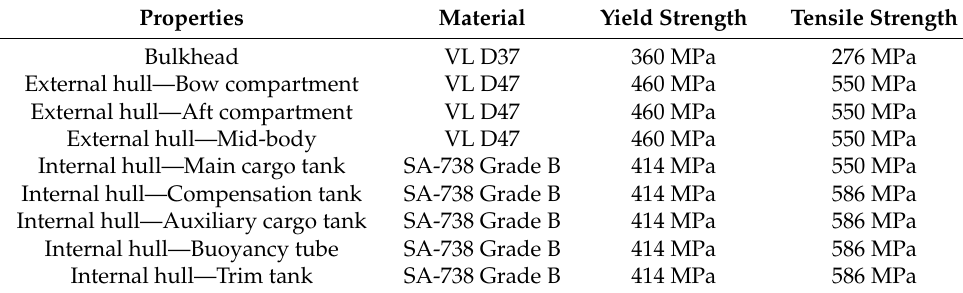
Table 2. Materials selected for the SFG.